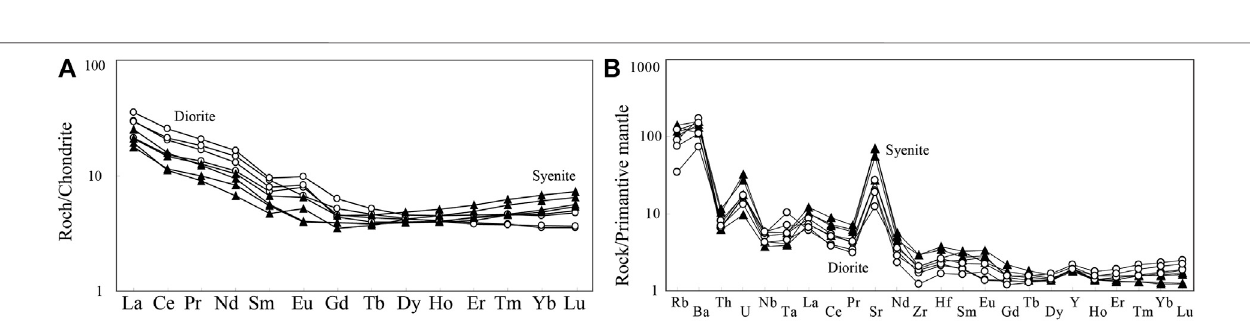
FIGURE 7 | Chondrite-normalized REE patterns (A) and the primitive mantle-normalized multi-element plots (B) for syenites and diorites in the Qiaer ’ dunbasixi deposit (modi fi ed from Wang and Zhu, 2010). Normalized values after Sun et al., 1989.